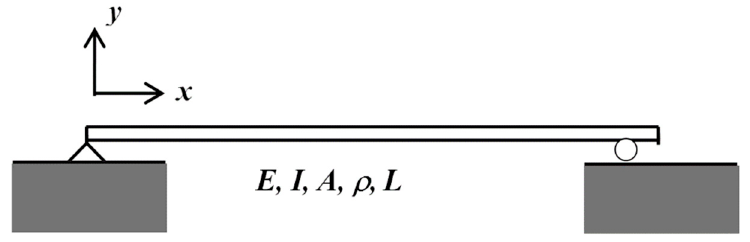
Figure 6. Simply supported beam.